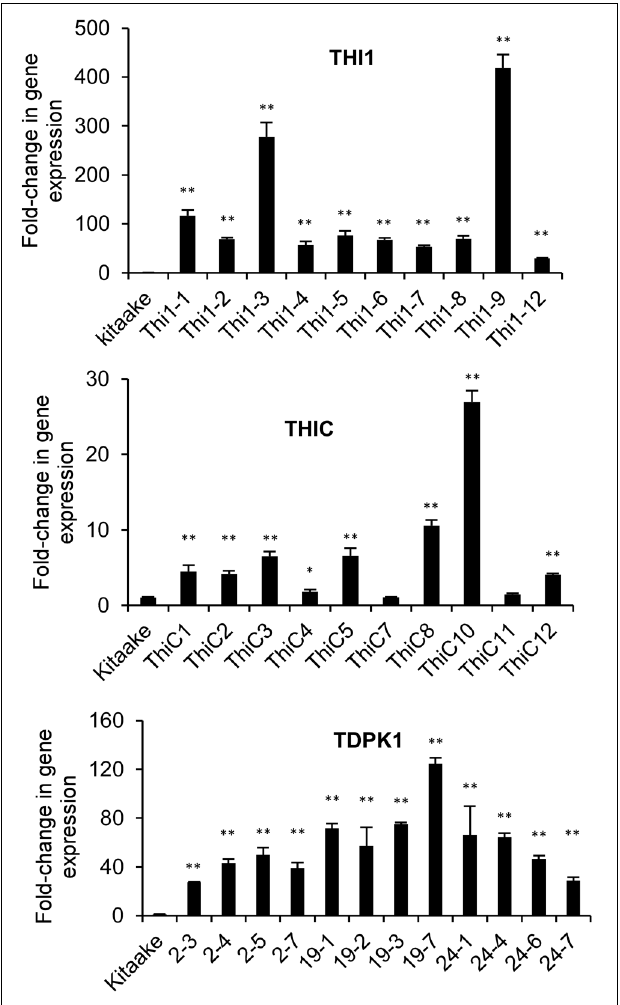
FIGURE 3 | Quantification of THI1 , THIC , and TDPK1 gene expression in leaf of transgenic THI1, THIC, and TDPK1 plants by real-time quantitative RTPCR. T 0 generations were used for THI1 and THIC , T 1 generation was used for TDPK1 . Each line used was positive by